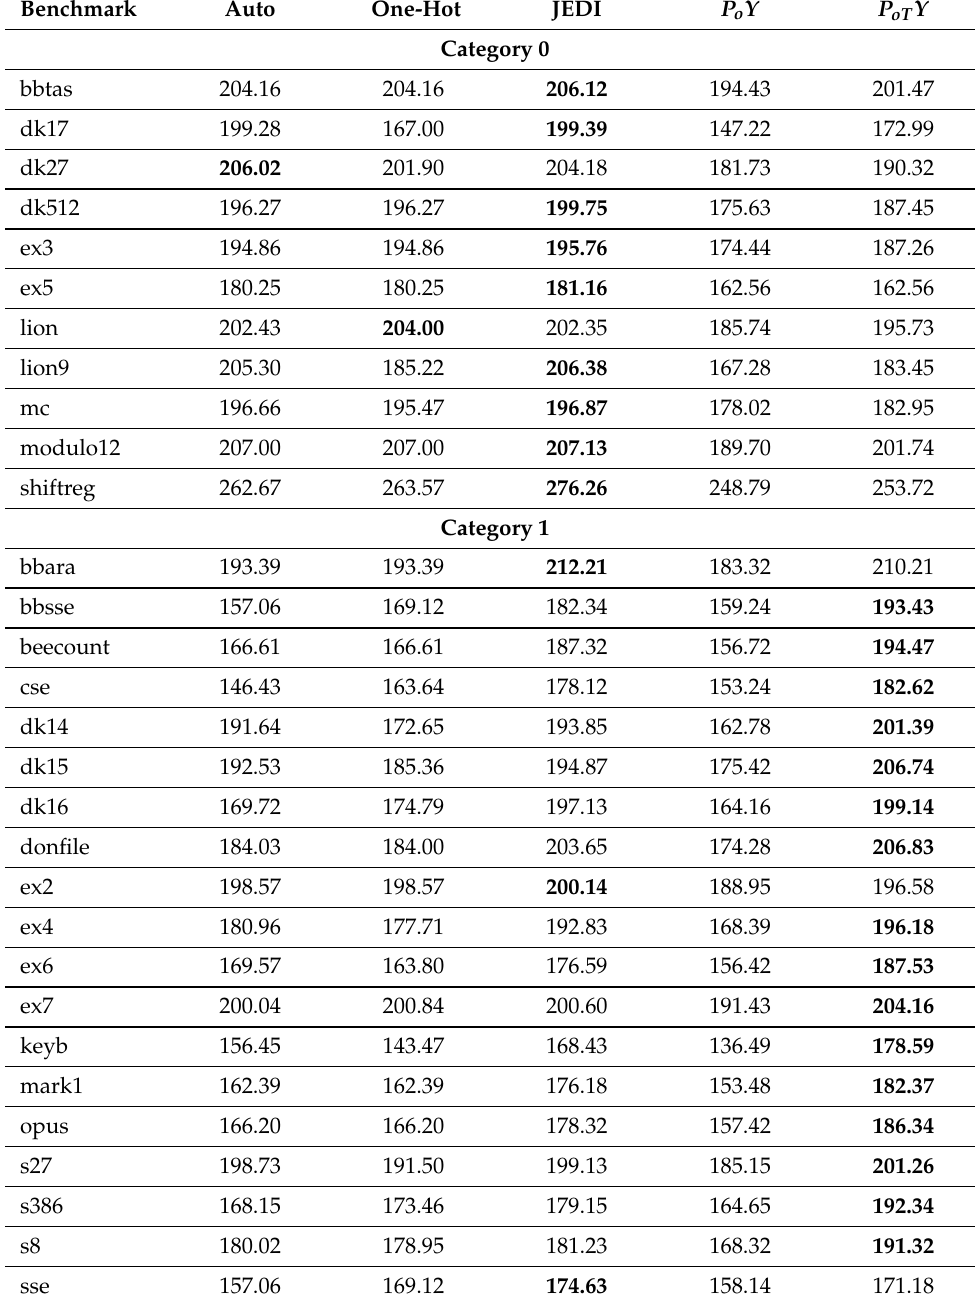
Table 17. Experimental results [132] (the maximum operating frequency,